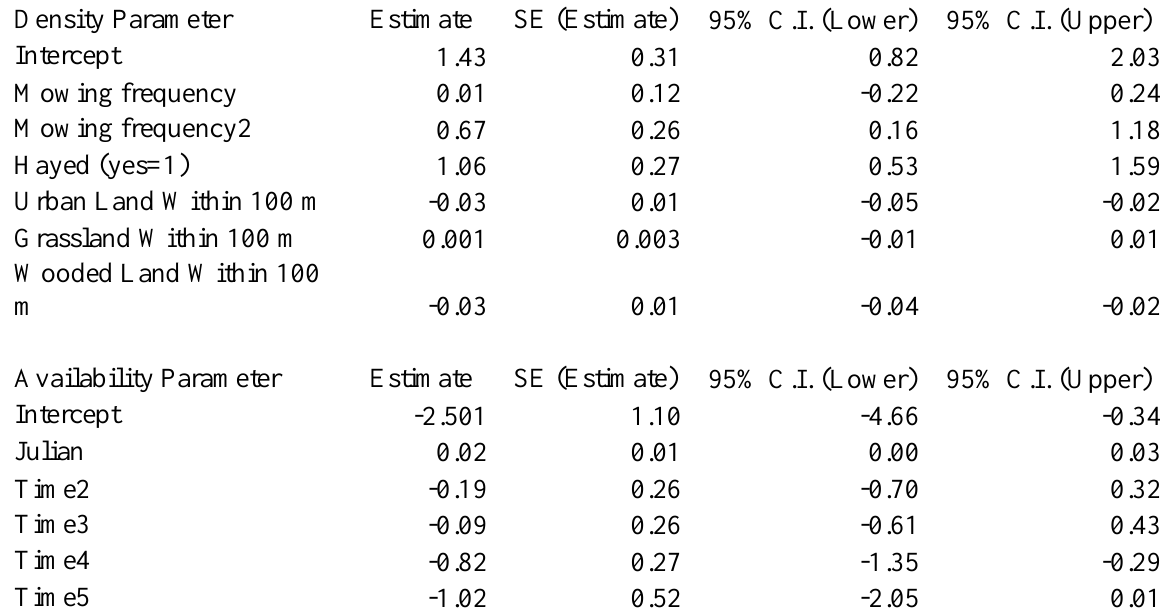
Table A2.L . Final hierarchical distance-sampling model (AIC weight=0.87) for Savannah Sparrows along 44 transmission line study sites in Winnipeg, Manitoba, Canada in 2009 (n=132 surveys), assuming a uniform detection probability with increasing distance of birds from the transect line and effects of Julian date and time of morning on availability for